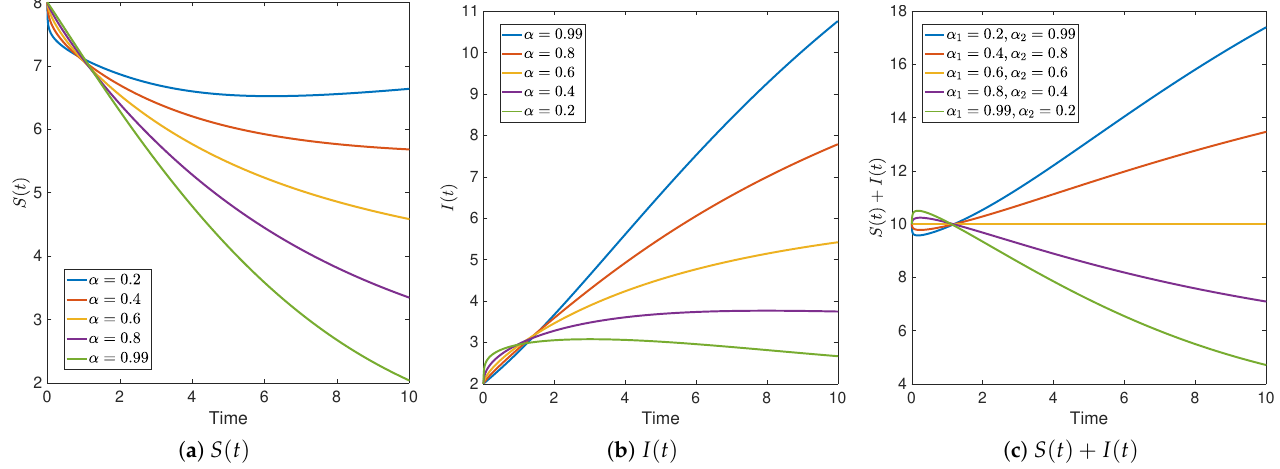
Figure 1. Numerical solutions to (1) with β = 0.7, γ = 0.2, I 0 = 2 and S 0 = 8.